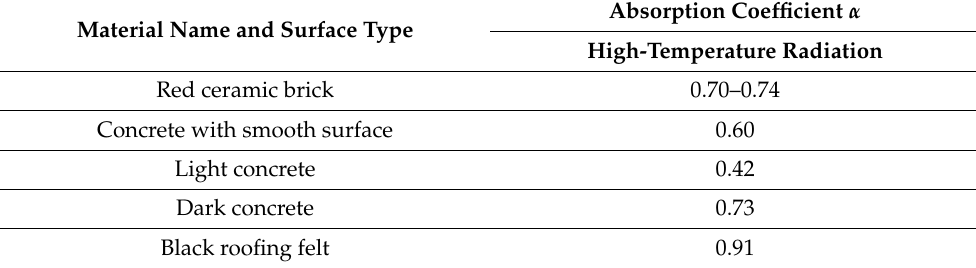
Table 3. Absorption coefficients for the selected materials based on the values given in